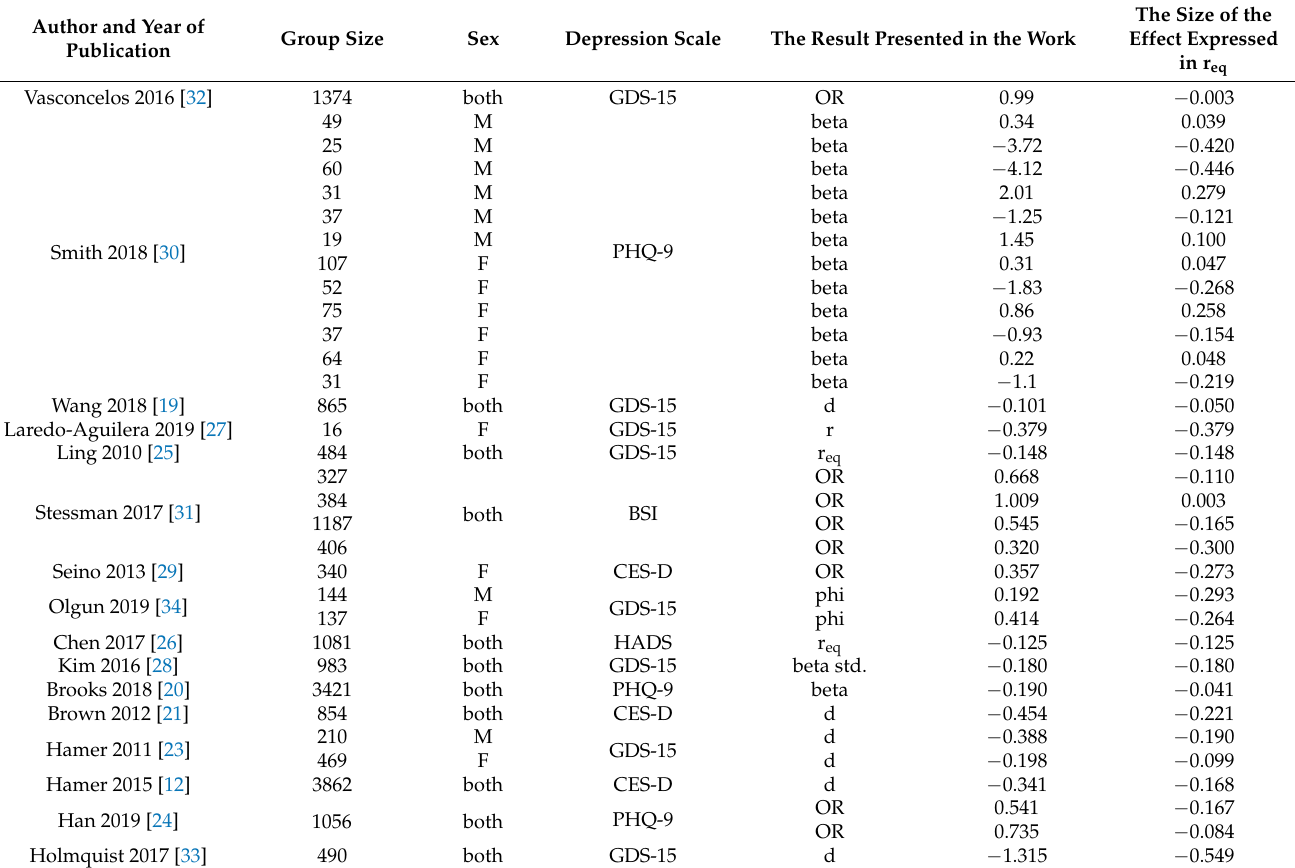
Table 3. Statistical presentation of the relationship between HGS and depression in the analyzed